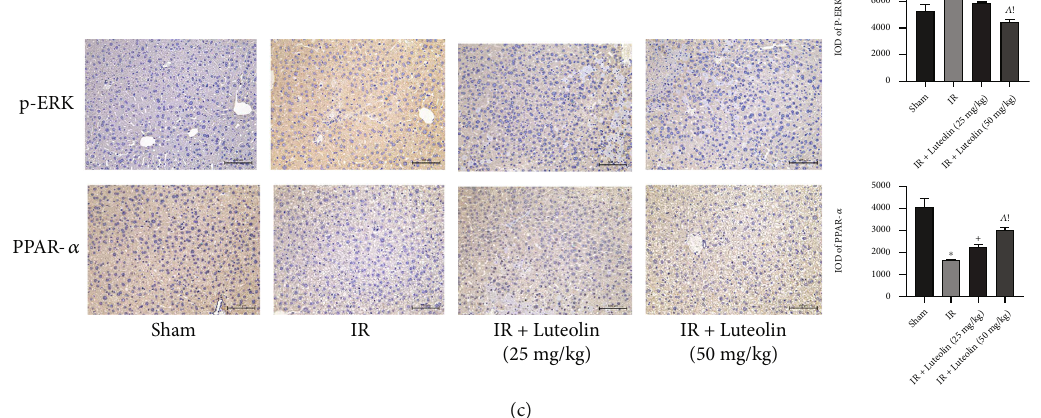
Figure 5: The protective e ff ect of luteolin during hepatic IR injury is closely related with ERK/PPAR α pathway. (a) Relative PPAR α mRNA levels were determined by qRT-PCR. (b) Western blot results and analysis of total ERK, p-ERK, and PPAR α levels. (c) Levels of p-ERK and PPAR α in liver tissues at 6 hours after reperfusion are shown by immunohistochemical staining. Final evaluations were made by Image-Pro Plus 6.0 software to calculate the IOD of the positive staining area. Data are presented as mean ± SD ( n = 6 ; ∗ p < 0 : 05 for IR vs. sham; + p < 0 : 05 for IR+luteolin (25 mg/kg) vs. IR; ^ p < 0 : 05 for IR+luteolin (50 mg/kg) vs. IR; ! p < 0 : 05 for IR+luteolin (50 mg/kg) vs. IR +luteolin (25